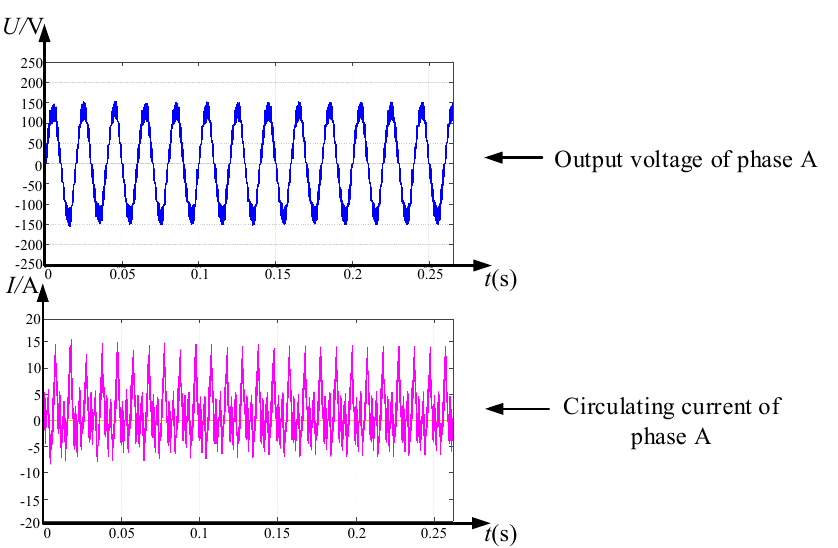
Figure 5. Waveform of the output voltage and the circulating current of phase A when θ = 0.